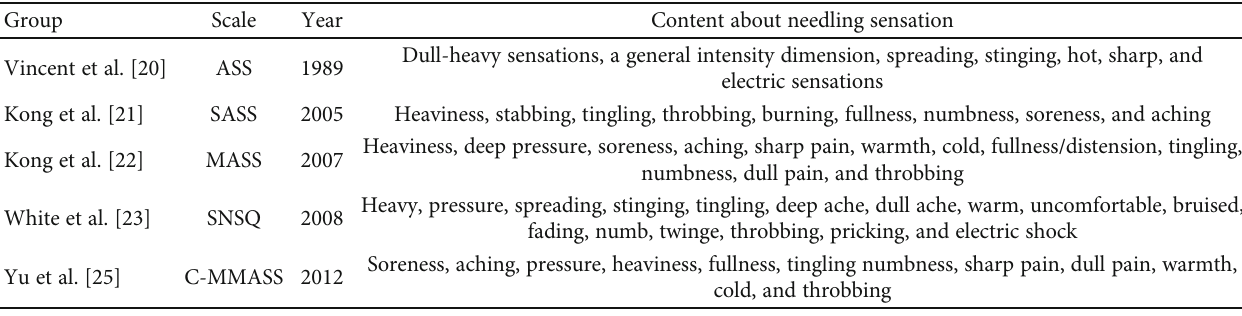
Table 1: The contents of representative acupuncture sensation scales.